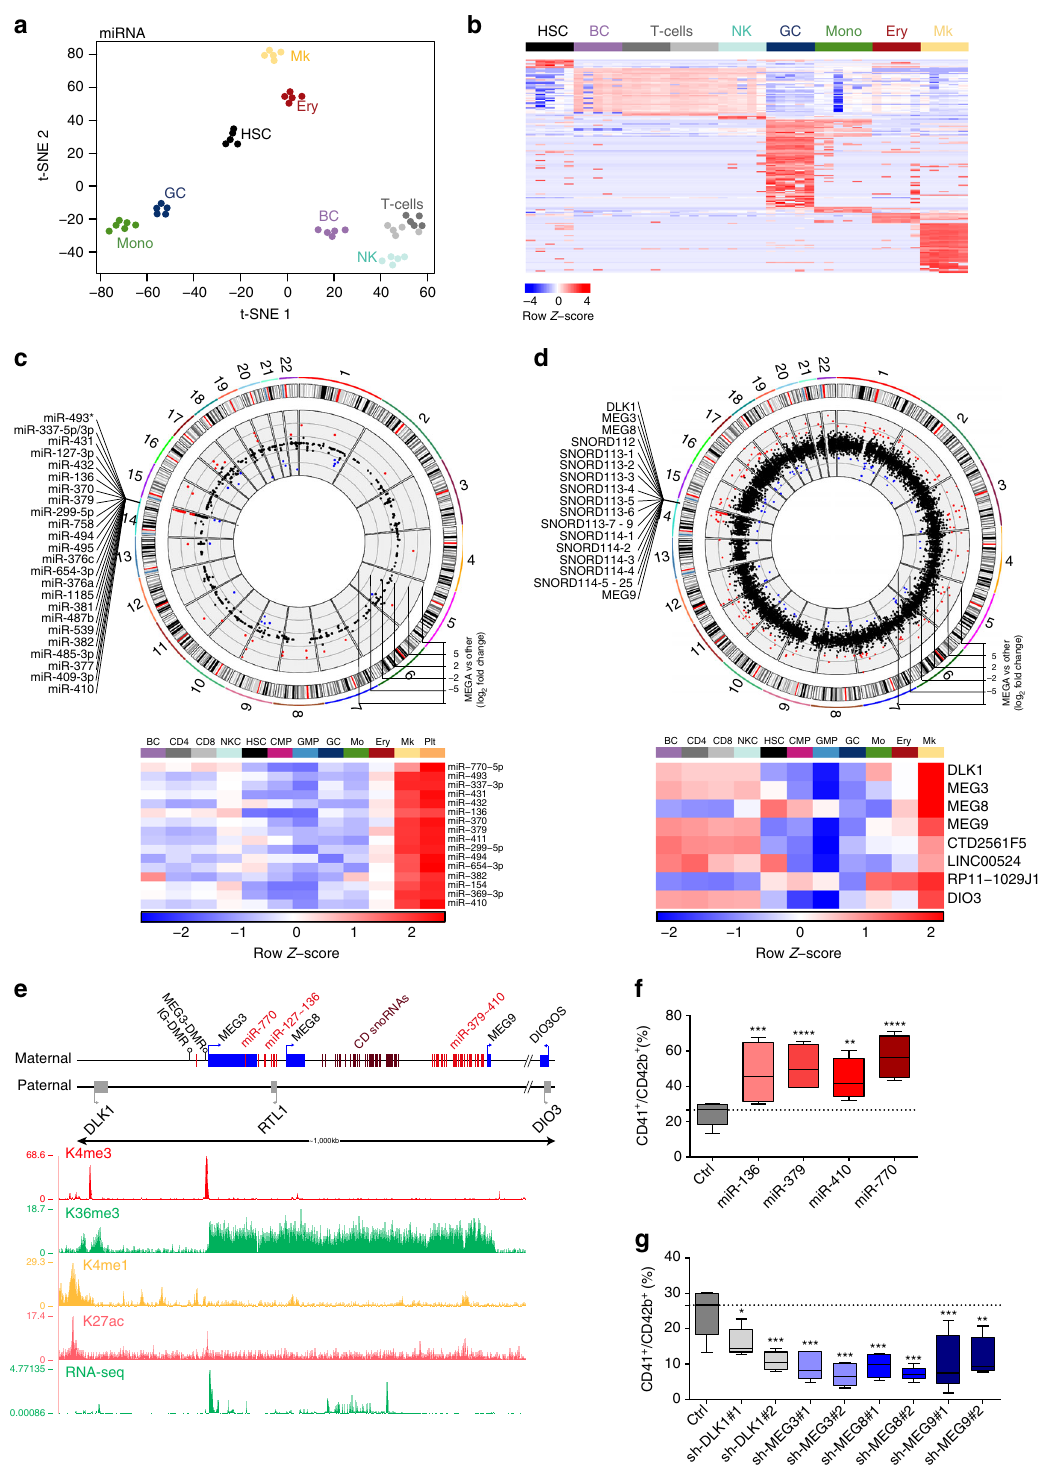
Fig. 5 ncRNAs of the DLK1-DIO3 locus control human megakaryopoiesis. a t -SNE of all samples using 240 variance- fi ltered miRNAs from the NCode Human miRNA Microarray V3 platform. b Heat map of 174 cell-type-speci fi c fi ngerprint miRNAs. c , d Genome-wide view of log 2 -FC for c miRNAs (NCode Human miRNA Microarray V3) and d ncRNAs (NCode Human Long Non-coding RNA microarray) in megakaryocytes compared to all other cell types. Red dots : log 2 -FC ≥ 3. The heatmaps show qRT-PCR validation results of z -score transformed 2 ΔΔ Ct values. e Schematic of the imprinted DLK1-DIO3 locus on human chromosome 14. Below are UCSC genome browser tracks (GRCh38/hg38) of ChIP-seq and RNA-Seq data in CD41 + megakaryocytic cells 24 . f Lentiviral expression of miR-770, miR-136, miR-379, and miR-410 ( n = 4) and g RNAi (shRNA)-mediated knockdown of DLK1, MEG3, MEG8 , and MEG9 ( n = 5) in CD34 + HSPCs in vitro. Both plots show the percentage of CD41 + /CD42b + cells. f , g Data are presented as mean ± s.e.m. * P < 0.05; ** P < 0.01; *** P < 0.001; **** P < 0.0001; ns not signi fi cant; P -values were calculated using one-way ANOVA with Dunnett ’ s post hoc